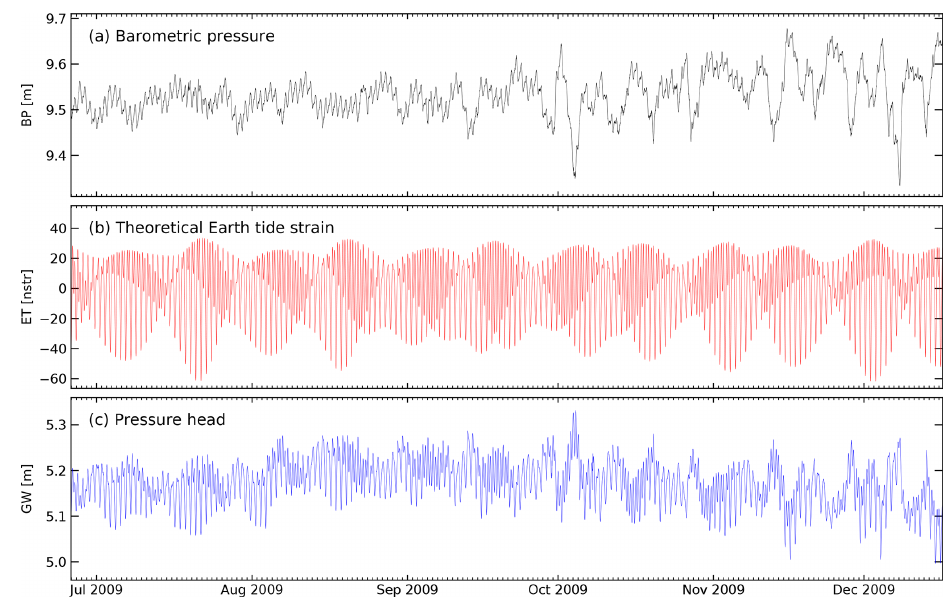
Figure 2. Time series of (a) barometric pressure (BP). (b) Theoretical Earth tide strains (ET) were calculated for the same duration and sampling rate and the well’s geo-location using PyGTide (Rau, 2018) and (c) well water levels (GW), as measured in the well BLM-1 in Death Valley (California, USA). The vertical axes for BP and GW are limited to the same range for a visual comparison.